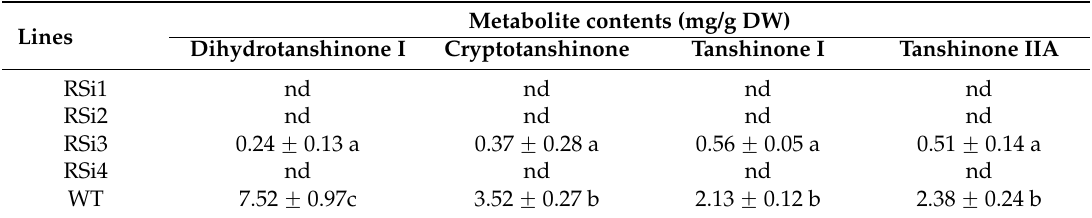
Table 1. The tanshinones contents in S. miltiorrhiza transgenic hairy roots at the end of the culture time.